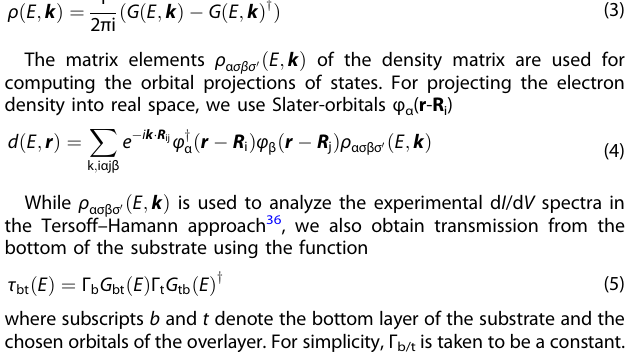
Supplementary Tables 1 and 2 for details. The main difference in our parameterization compared to that of ref. 26 is that we consider three